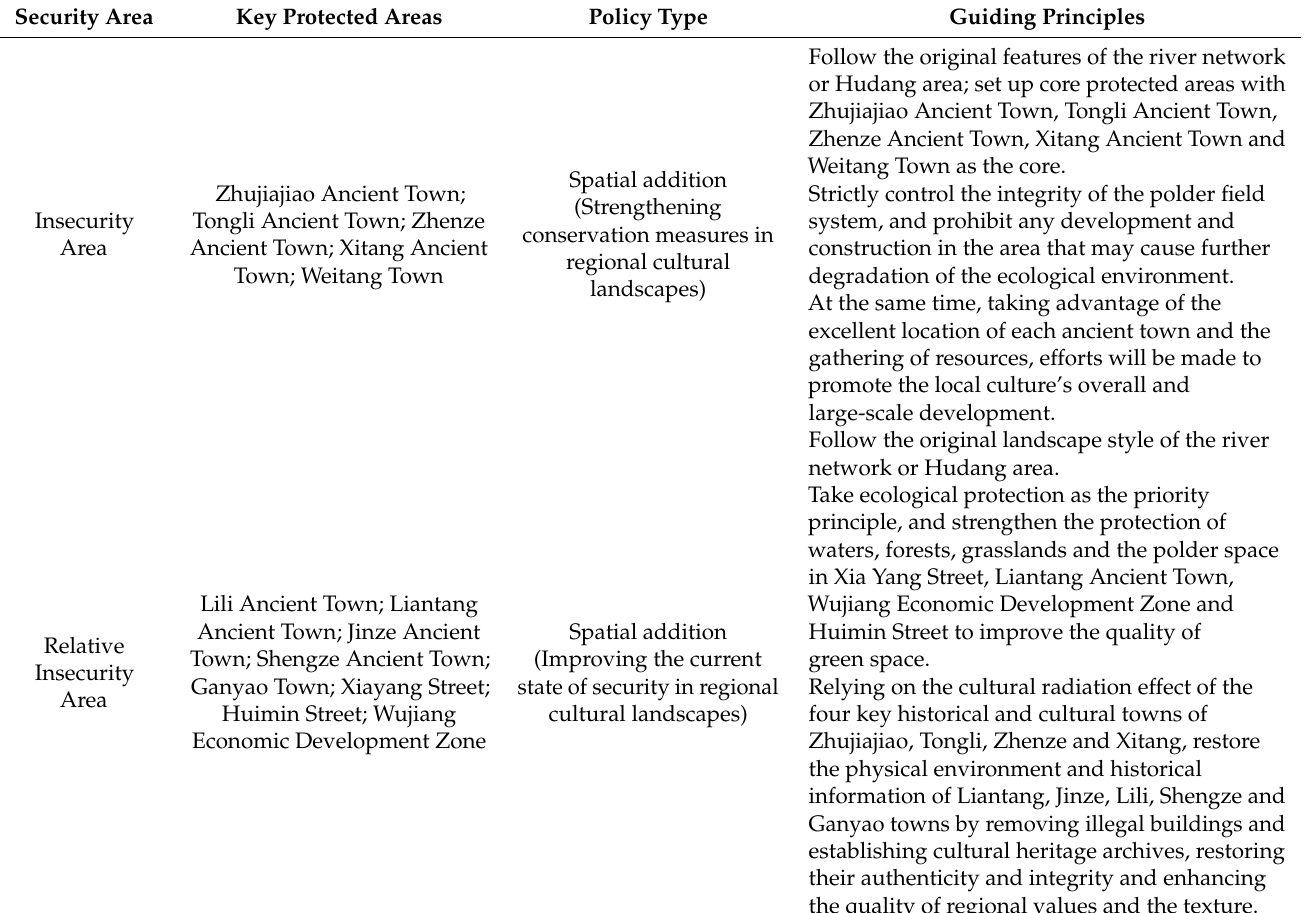
Table 7. Hierarchical optimization strategy of the different cultural landscape security zones in the demonstration